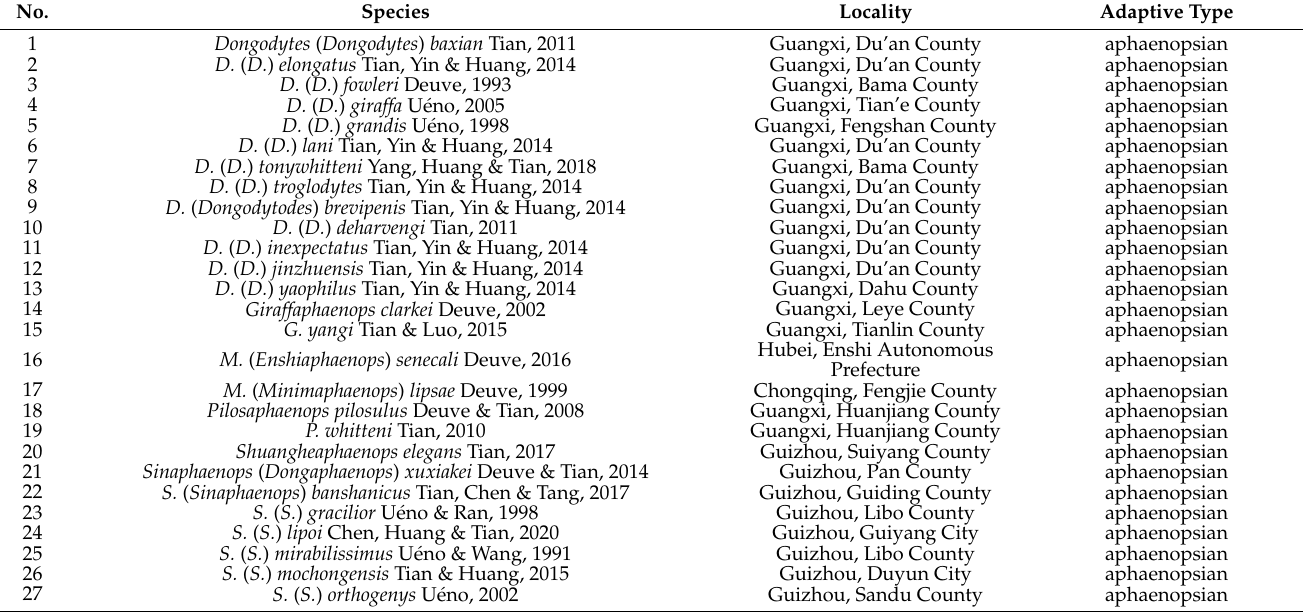
Table A1. Basal information of the studied specimens used in the geometric morphometric analysis.